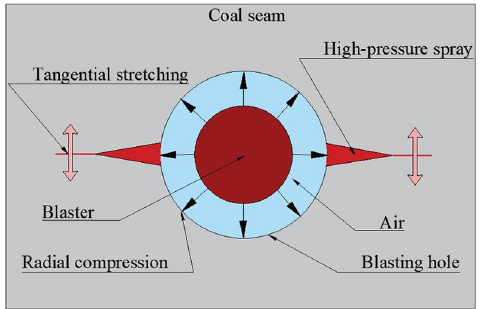
Fig 2. Mechanical model of fracture by liquid CO 2 blasting in a coal